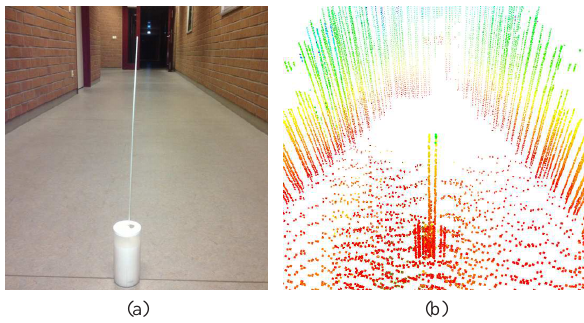
Figure 8: Perception of small obstacles: (a) rod with 2.5 mm di- ameter; (b) resulting 3D point cloud (pixel color encodes height above ground